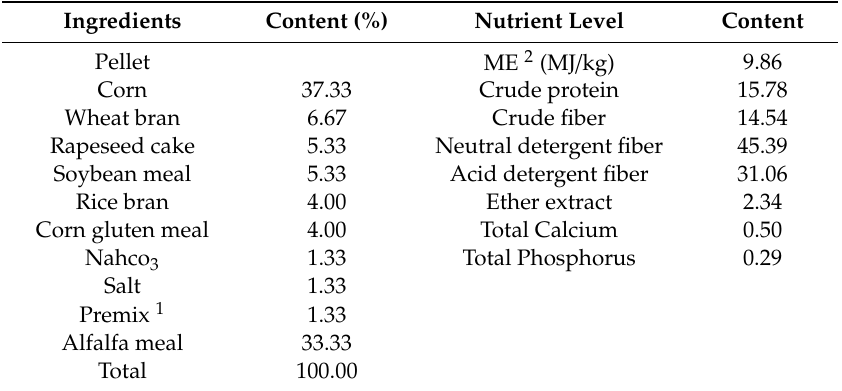
Table 1. Composition and nutrient level of diet (Dry-matter basis,